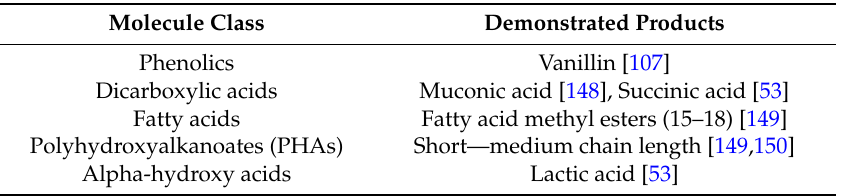
Table 5. Biological lignin